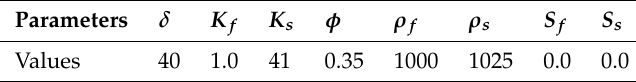
Table 2. Parameters and properties of the